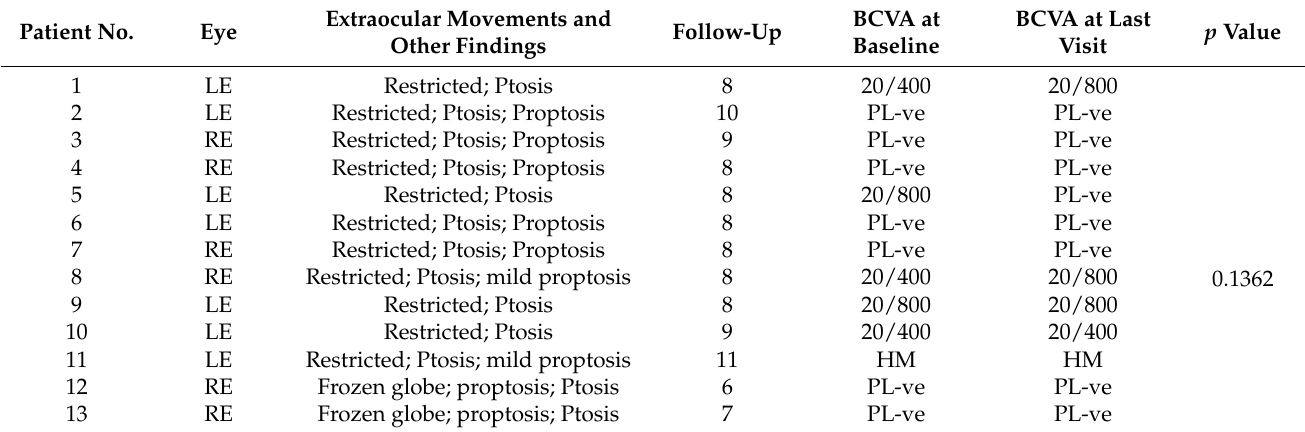
Table 2. Ocular features of eyes of patients with vison-threatening